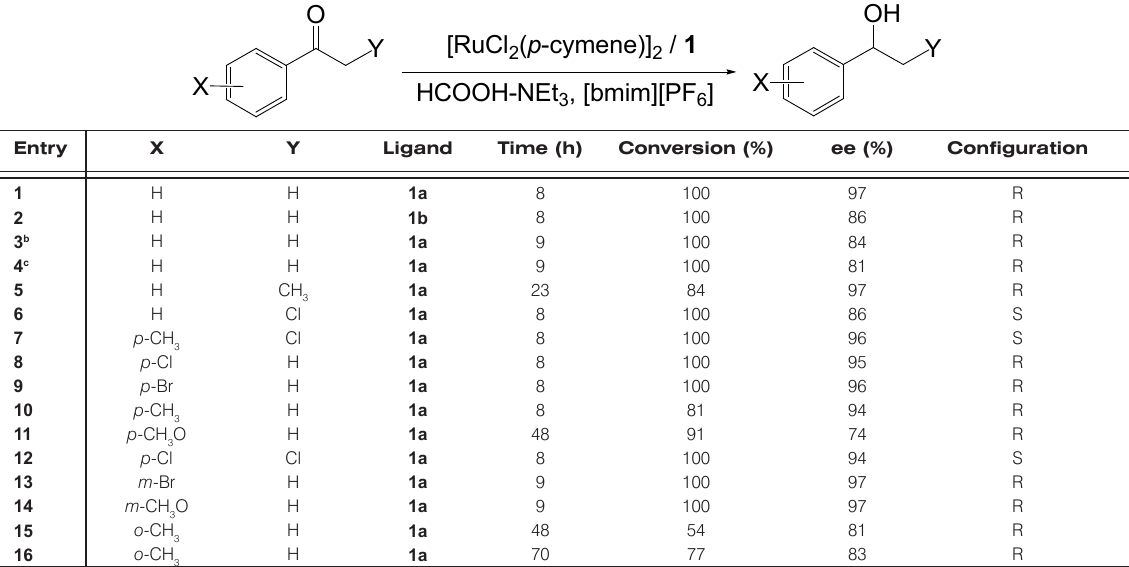
Table 1. Asymmetric transfer hydrogenation of prochiral ketones in [bmim][PF